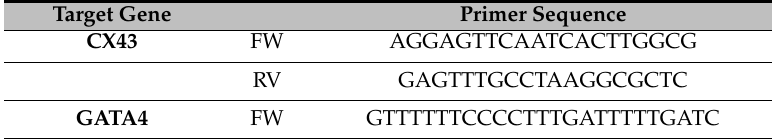
Table 1. List of primer sequences for real-time qPCR and semi-quantitative PCR